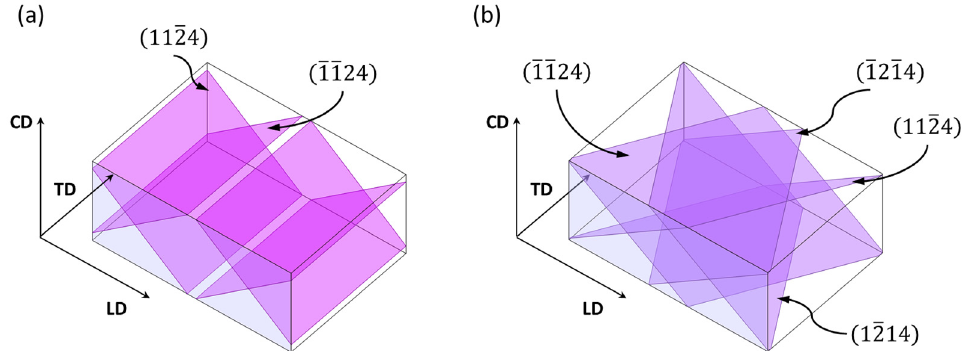
Figure 19. Alignment of 1124 fracture planes in specimens of ( a ) orientation A and ( b ) orientation B with respect to the sample reference frame LD ‐ TD ‐ CD.